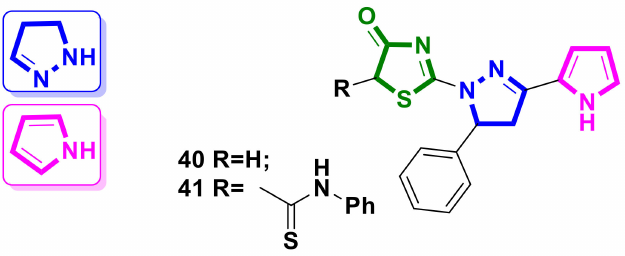
Figure 16. Structure of pyrazoline-pyrrole–4-thiazolidinone hybrid molecules.